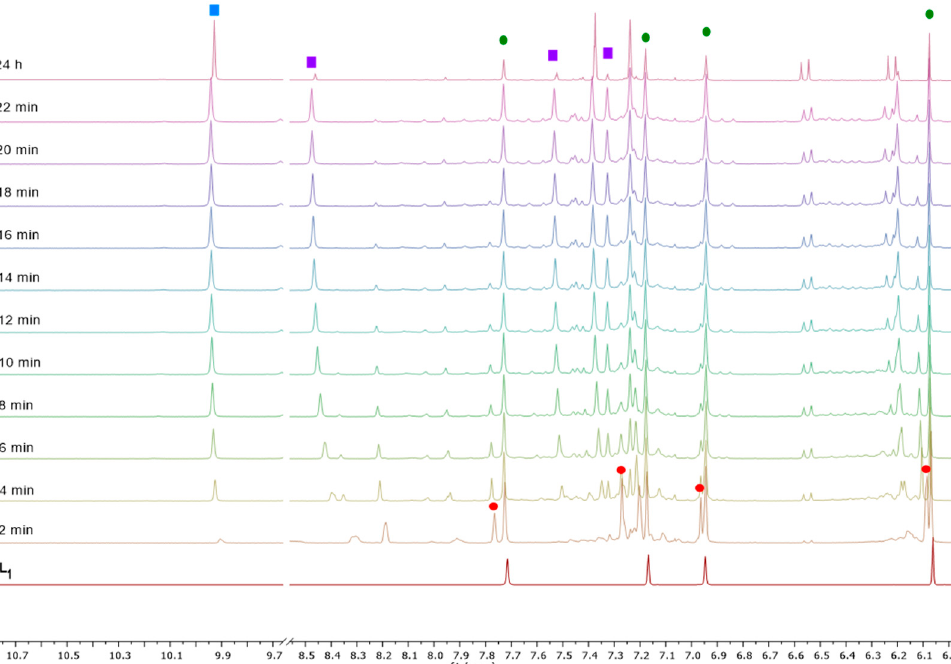
Figure 1. NMR 1 H (500 MHz) monitoring of the reaction between [Ru( p -cym)Cl 2 ] 2 and L 1 in MeCN- d 3 . Signal assignments: L 1 —red circles; Ru– L 1 intermediate complex—green circles; Ru–imidazole complex—purple squares; formaldehyde—blue square.